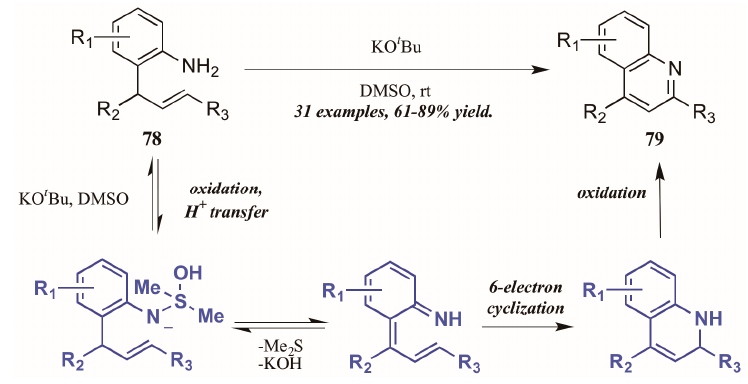
Figure 35. DMSO-mediated oxidative cycloisomerization.